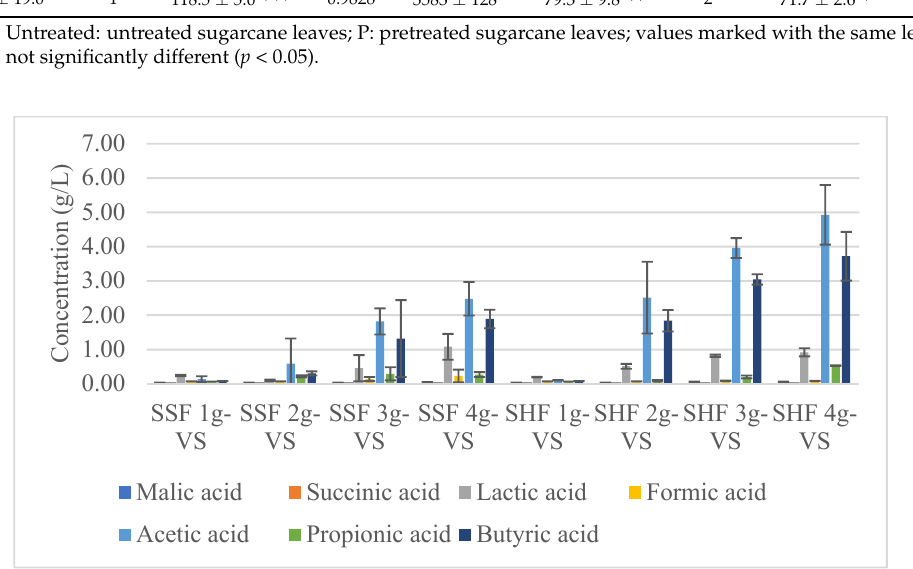
0.9793 Untreated: untreated sugarcane leaves; P: pretreated sugarcane leaves; values marked with the same letters are not significantly different ( p < 0.05).